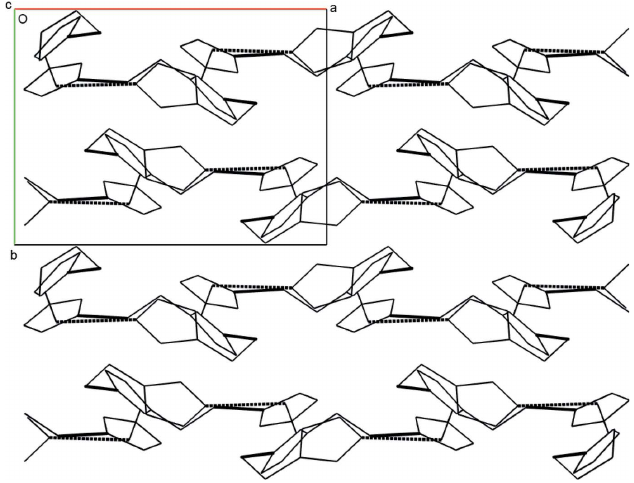
Figure 2 The packing arrangement of the three-molecule supermolecule with hydrogen bonds represented as dashed lines as viewed along the a axis of the unit cell. The approximate diameter of each three-member super- molecule is 9–9.5 A˚ with a height of about 2.6 A˚ .